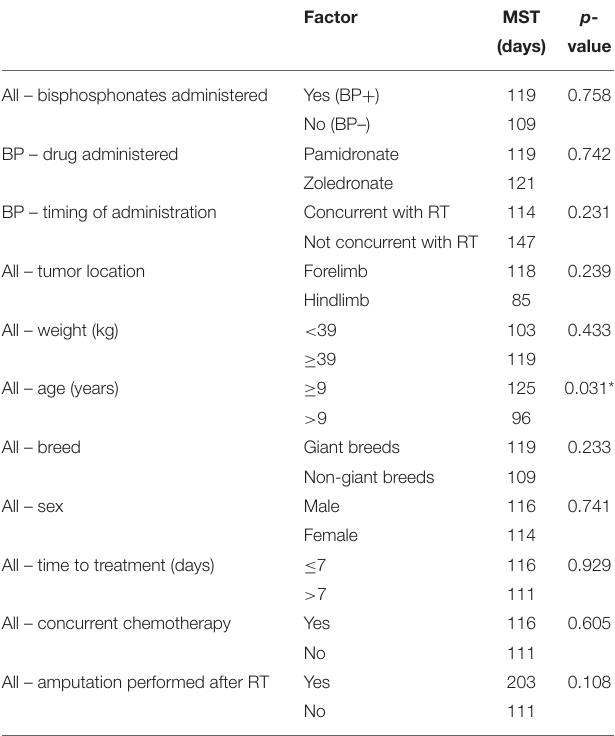
TABLE 2 | Median survival time for evaluated